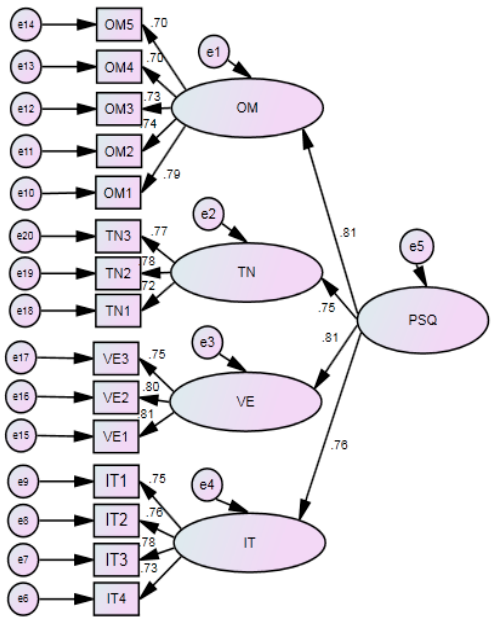
Figure 2. Confirmatory factor analysis: model 1.